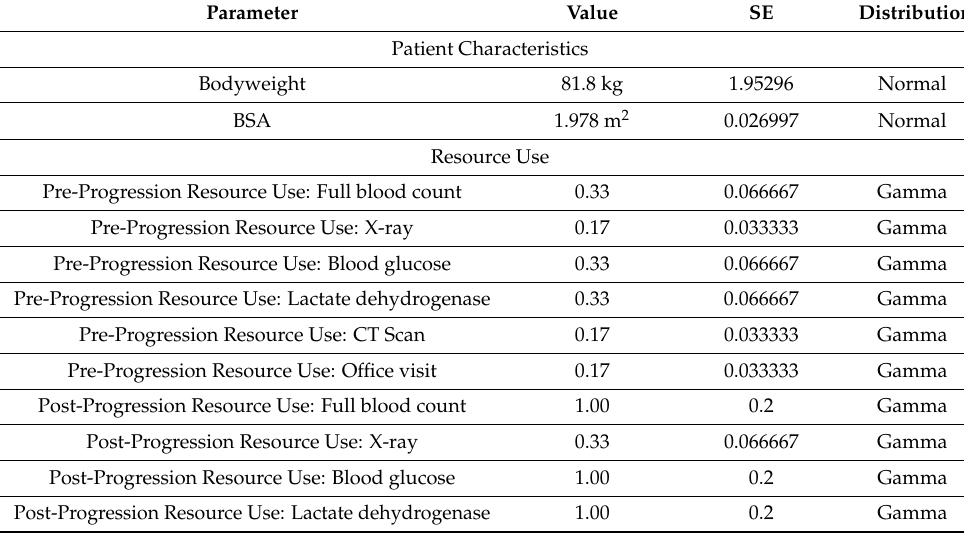
Table A9. Parameter values varied in probabilistic sensitivity